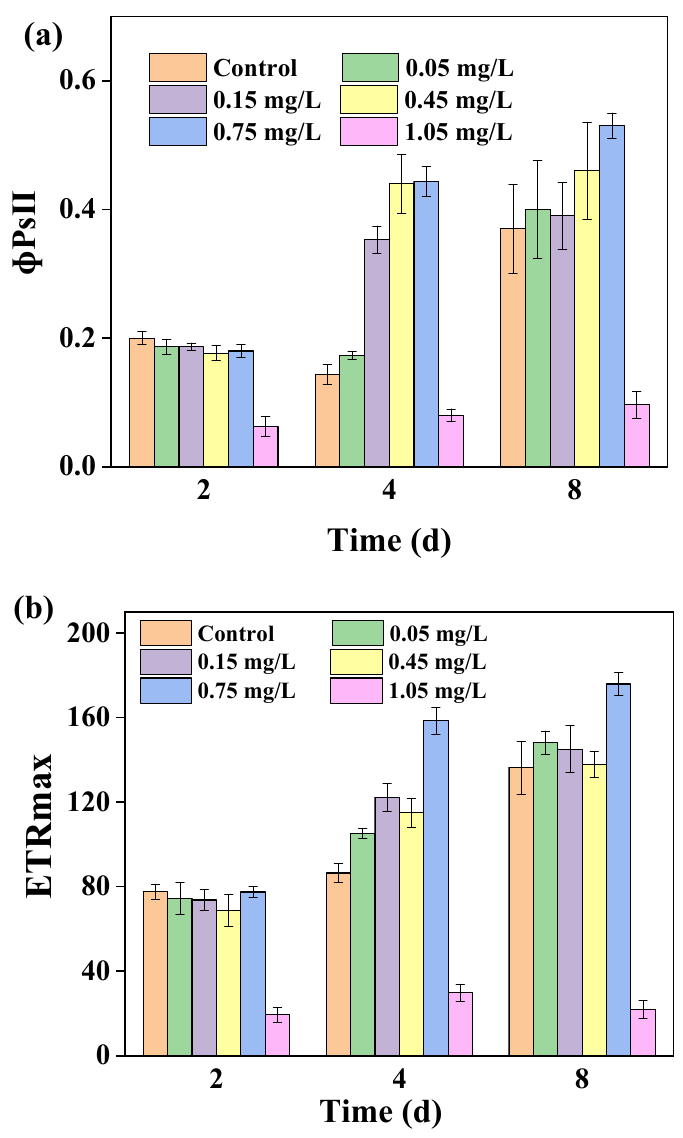
Figure 4. Effects of triclosan on the ϕ PSII ( a ) and ETRmax ( b ) of Chlorella vulgaris . The values of I k and α reflect the tolerance of microalgae to strong light and the efficiency of light energy utilization, respectively. Figure 5a showed that there was no effect exerted on the I k values of Chlorella vulgaris during the first two days of exposure to 0.00–0.75 mg/L triclosan. The tolerance to strong light was highly stimulated in low concentrations of triclosan (<0.75 mg/L) in algae from the 4th exposure day ( p < 0.01), and the extent of this increase was positively correlated with the exposure concentration. As shown in Figure 5b, the α values of Chlorella vulgaris did not change greatly along with triclosan stress at various concentrations (0–1.05 mg/L) in this study ( p > 0.05). However, compared to the control groups, the α values of Chlorella vulgaris significantly decreased ( p < 0.01) when exposed to 1.05 mg/L triclosan. Therefore, the results illustrate that low- concentration (<0.75 mg/L) triclosan may improve the strong light tolerance and utilization ability of Chlorella vulgaris